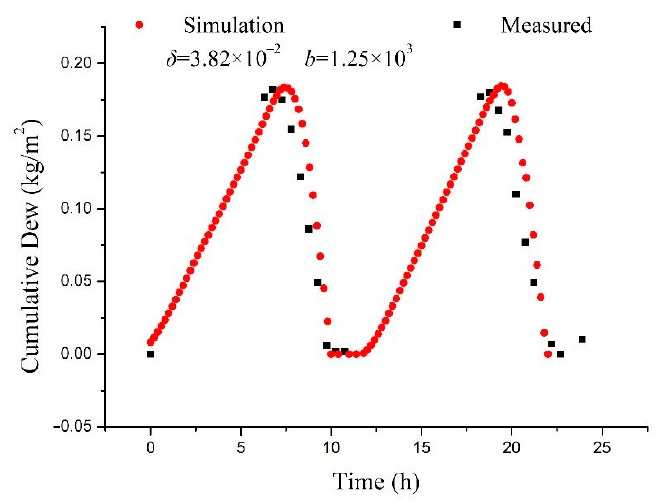
Figure 8. Measured cumulative amount of dew collected in a desert system [18] and simulated curve.